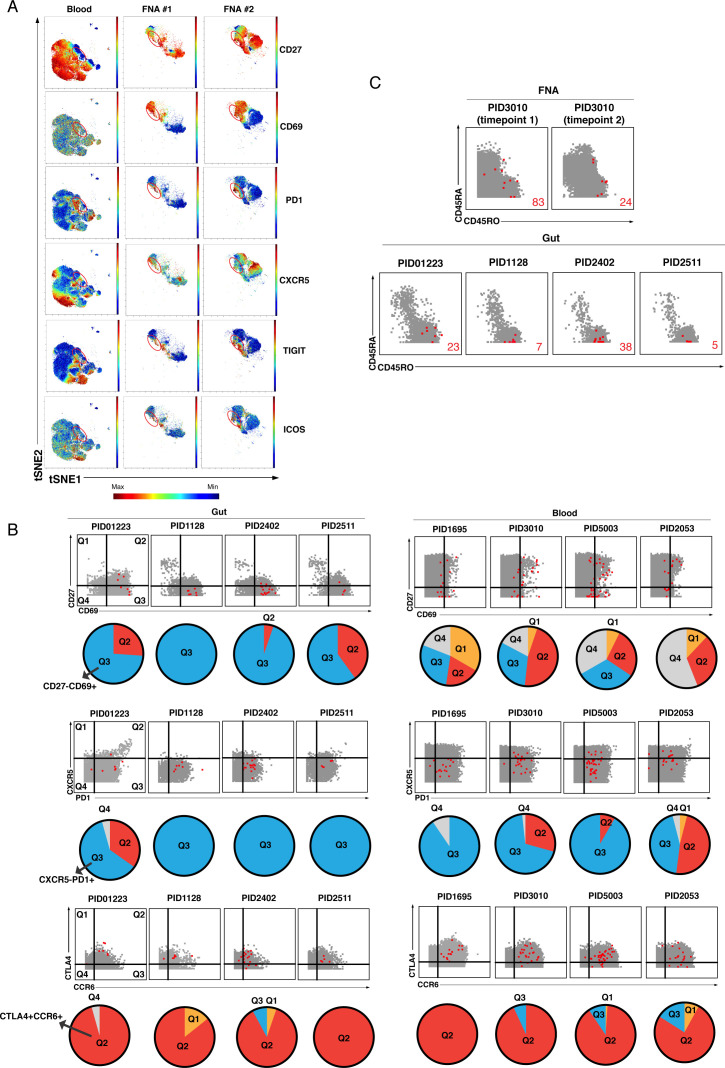
Comparison of kNN latent cells from blood and tissues.(A) The tSNE maps presented in Figure 4C are portrayed as heatmaps showing expression levels of CD27, CD69, PD1, CXCR5, TIGIT, and ICOS. Regions with the highest density of kNN latent cells shown in Figure 4C are circled in red. Dot plot and pie graph depictions of the same datasets are presented in Figure 4D. (B) Dot plots comparing the expression patterns of CD27, CD69, CXCR5, PD1, CTLA4, and CCR6 on kNN latent cells from the gut and blood. In the dot plots, kNN latent cells are depicted in red and atlas cells in gray. The proportions of kNN latent cells that fall within each quadrant are depicted as pie charts beneath each dot plot. Top: Most kNN latent cells from the gut reside in quadrant 3 (Q3), corresponding to cells expressing high levels of CD69 and low levels of CD27. Middle: Most kNN latent cells from the gut reside in Q3, corresponding to cells expressing high levels of PD1 and low levels of CXCR5. Bottom: Most kNN latent cells from the gut reside in quadrant 2 (Q2), corresponding to cells expressing high levels of CTLA4 and CCR6. (C) kNN latent cells from FNAs but not the gut include naïve CD4+ T cells. Dot plots showing kNN latent cells (red) and atlas cells (gray) for two FNA and four gut specimens. Events were pre-gated on CD4+ T cells (CD3+CD8-CD19-). Naïve cells are visualized as those expressing high levels of CD45RA and low levels of CD45RO. These naïve cells also expressed high levels of CD27 and CCR7 (not shown). Red numbers indicate the number of kNN latent cells in each plot.